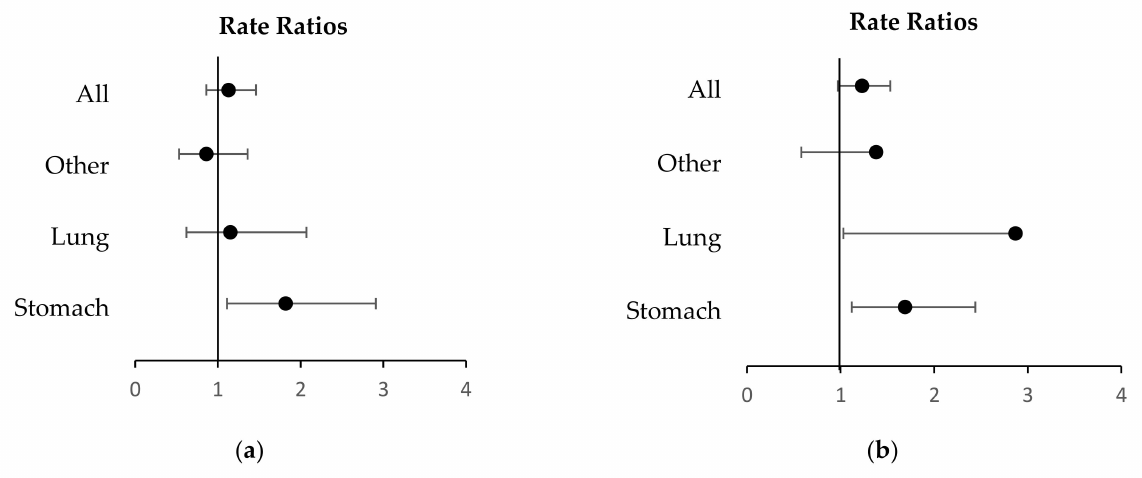
Figure 2. Forest plot with Rate Ratios for comparison: ( a ) study regions with Cr (VI) in drinking water and study regions without Cr (VI) in drinking water; ( b ) study regions with Cr (VI) in drinking water and Liaoning Province. An RR = 1.0 indicates equal rates in the two groups. An RR > 1.0 indicates an increased risk for the group in the numerator. An RR < 1.0 indicates a decreased risk for the group in the